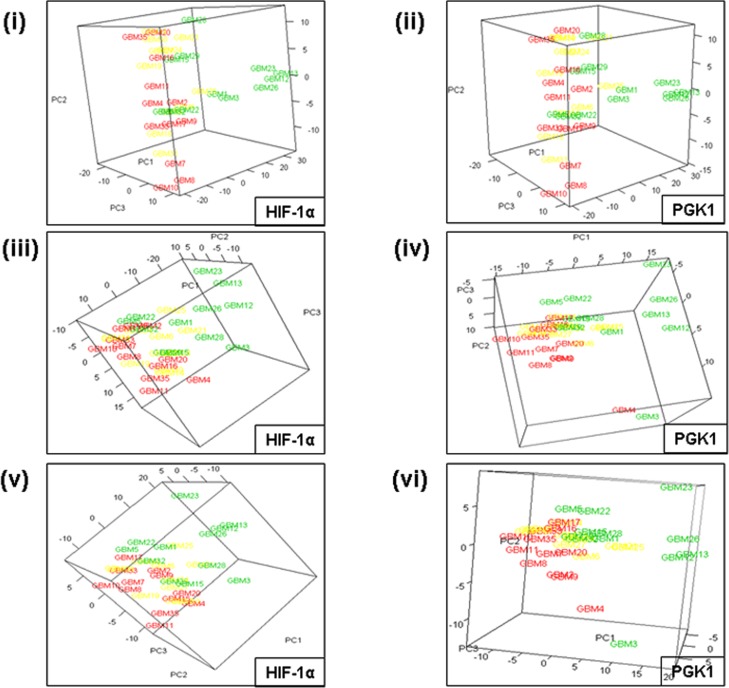
3D PCA plots showing clustering of GBM tumors belonging to HIF-1α tertiles and PGK1 tertiles on the basis of differential expression of Notch pathway genes.Colouring scheme in 3D plots: GBMs have been coloured as red data points for high tertile (12 tumors), yellow data points for intermediate tertile (11 tumors) and green data points for low tertile (12 tumors), respectively. Similar to 2D plots, the combinations of Notch genes used to create the principal components in each 3D plot were as follows: (i & ii) all 15 Notch genes; (iii) 9 genes (Notch1, Dll1, Dll4, Hes1, Hes2, Hes5, Hes6, Hey1, Hey2); (iv) 7 genes (Notch1, Dll1, Dll4, Hes1, Hes6, Hey1, Hey2); (v) 7 genes (Notch1, Dll1, Hes1, Hes2, Hes6, Hey1, Hey2); (vi) 6 genes (Notch1, Dll1, Hes1, Hes6, Hey1, Hey2). Both HIF-1α- and PGK1-ordering of the tumors produced well-separated clusters of high and low tertiles based on 15 or selected Notch genes’ expression.